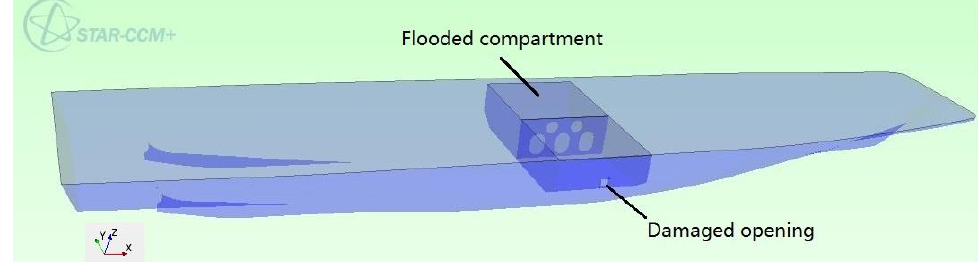
Figure 2. Body plan (Unit: mm).